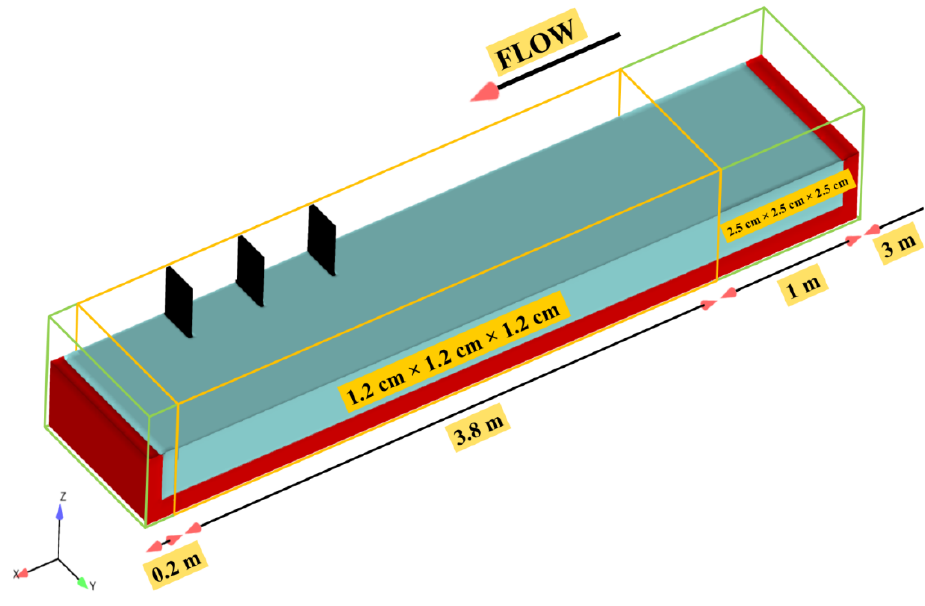
Figure 2. Sketch of mesh setup.